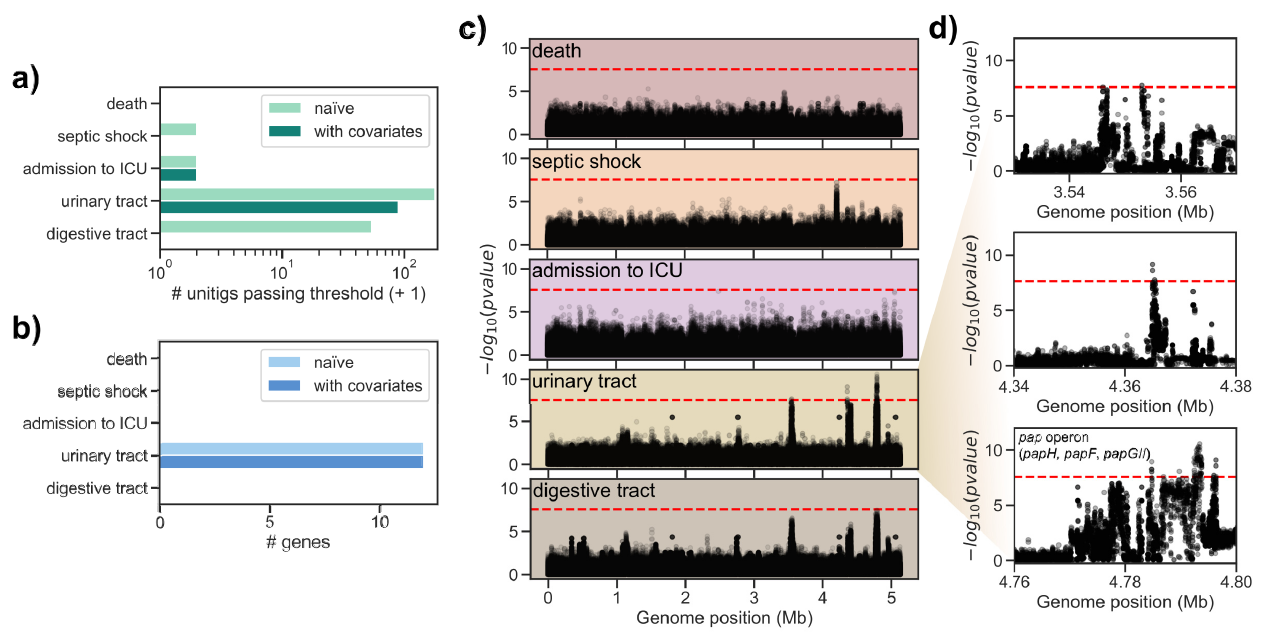
Fig 3. Genome-wide association analysis results on the combined dataset. a) Number of unitigs passing the multiple testing correction p-value threshold for each target phenotype. b) Number of genes with significantly associated unitigs mapped to them for each target phenotype. c) Manhattan plots for tested unitigs mapping to E . coli IAI39 for each target phenotype; red dashed line indicates the p-value threshold used to call significant associations. d) Zoomed-in Manhattan plots for the urinary tract trait. Genes annotated with a gene name in E . coli IAI39 and with associated unitigs are indicated in the third subpanel.